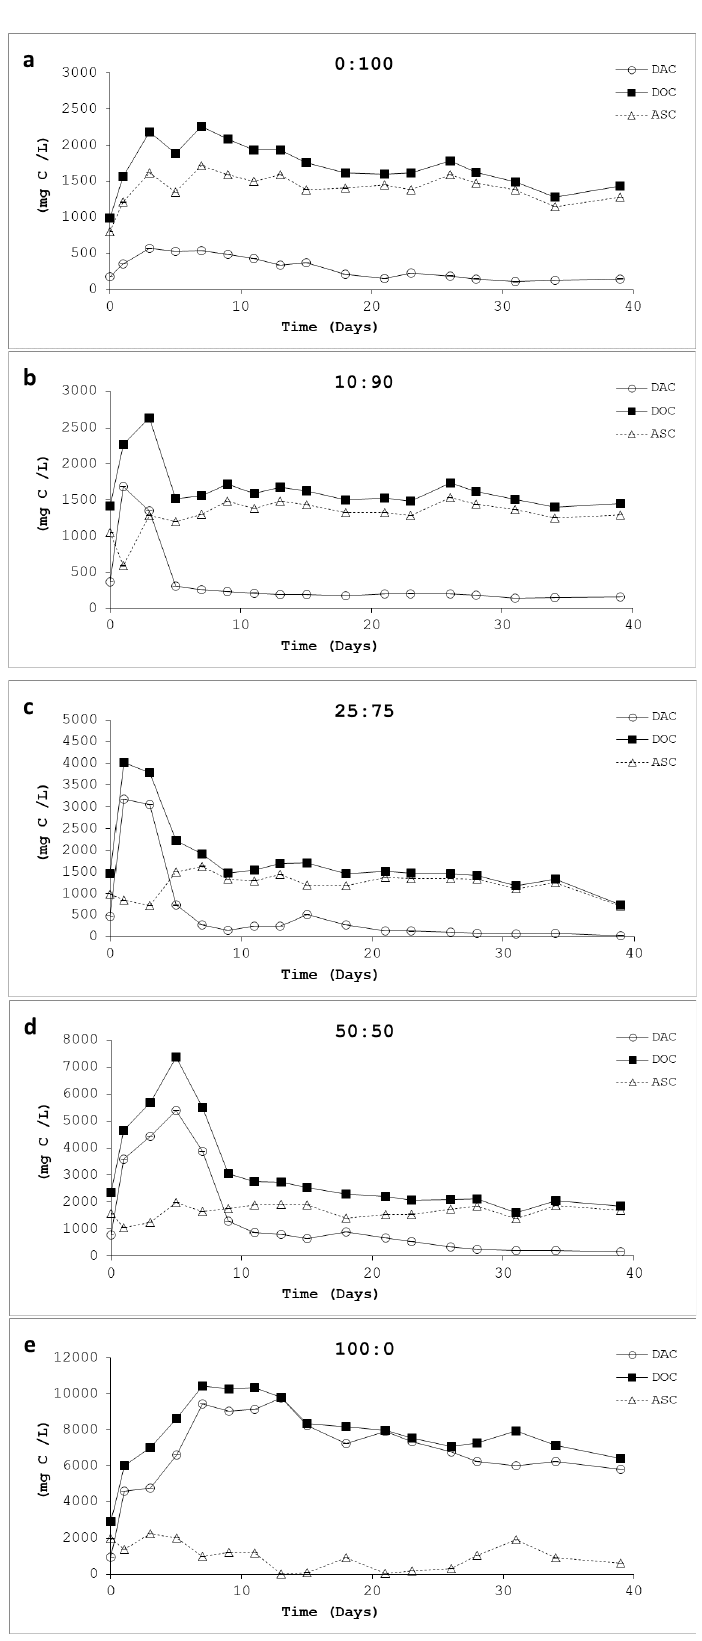
Figure 5. Evolution of dissolved organic carbon (DOC), dissolved acid carbon (DAC), and acidogenic substrate as carbon (ASC) in each reactor. ( a ) Reactor 0:100; ( b ) Reactor 10:90; ( c ) Reactor 25:75; ( d ) Reactor 50:50, and ( e ) Reactor 100:0.